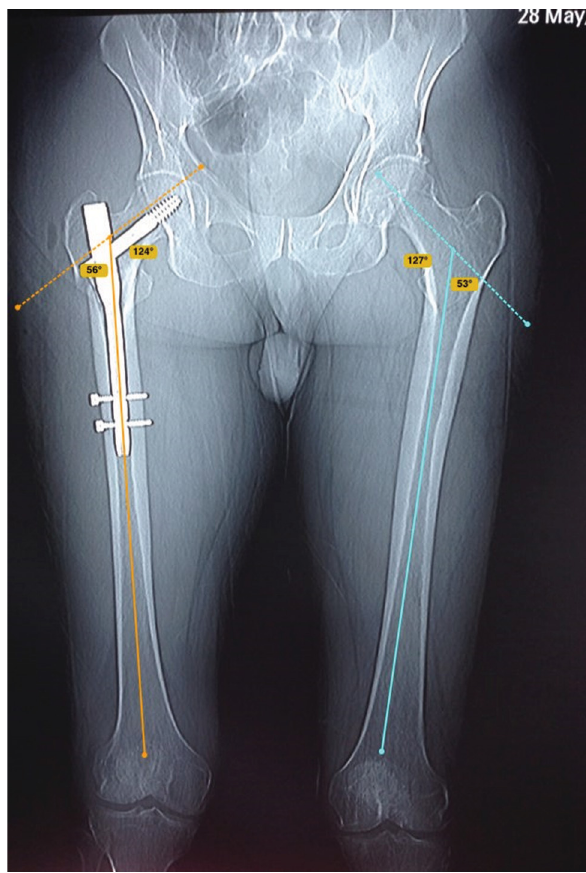
Figure 5. Measurement of neck-shaft angle on fractured and healthy side by Bone Ninja